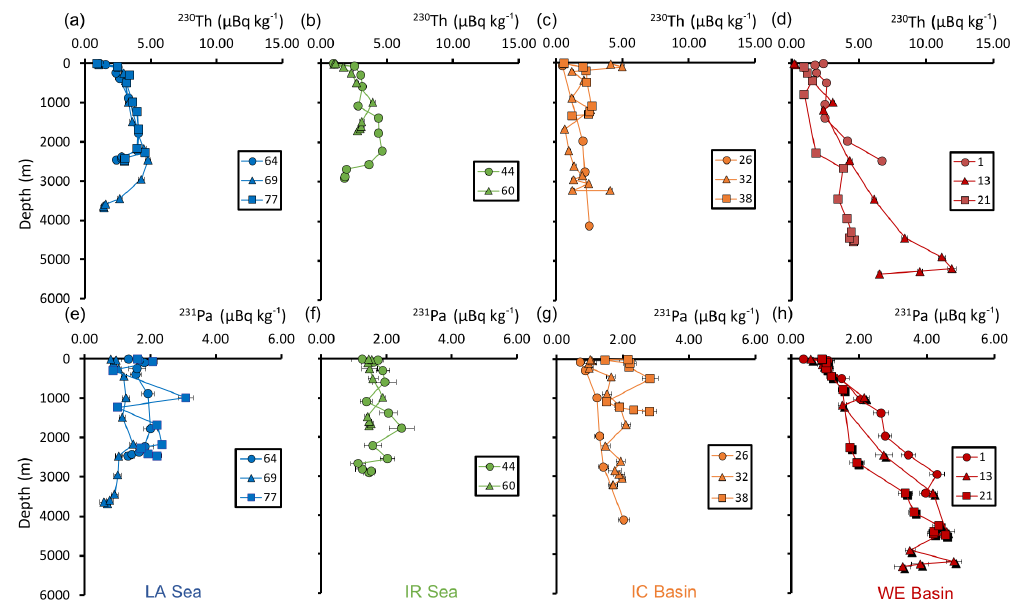
Figure 2. Vertical profiles of 230 Th (a–d) and 231 Pa (e–h) in the water column along the GEOVIDE section. Colours correspond to the region (as in Fig. 1). LA is Labrador, IR is Irminger, IC is Iceland, and WE is West European. Uncertainties represent 2 standard errors (2